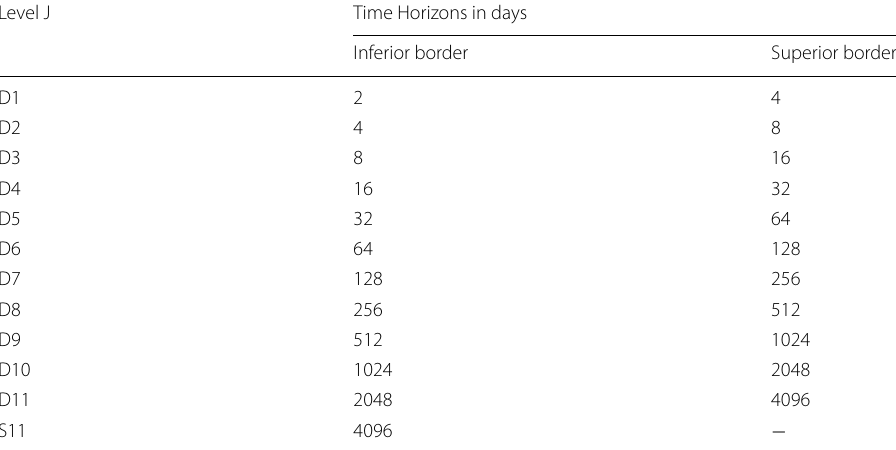
Table 11 Frequency Bands corresponding days Level